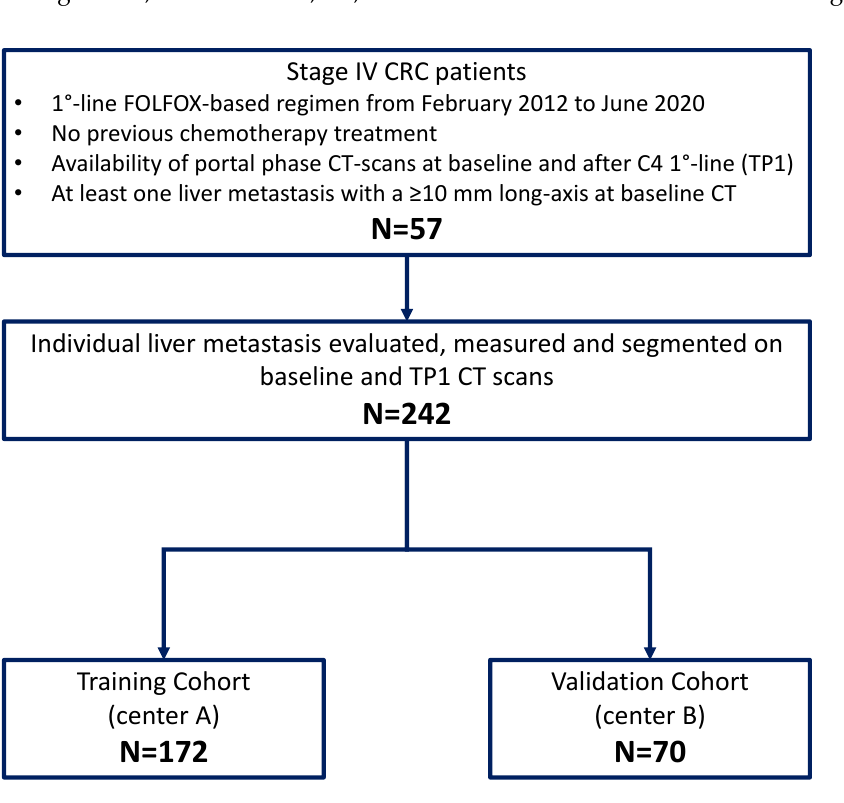
Figure 1. CONSORT flow diagram.